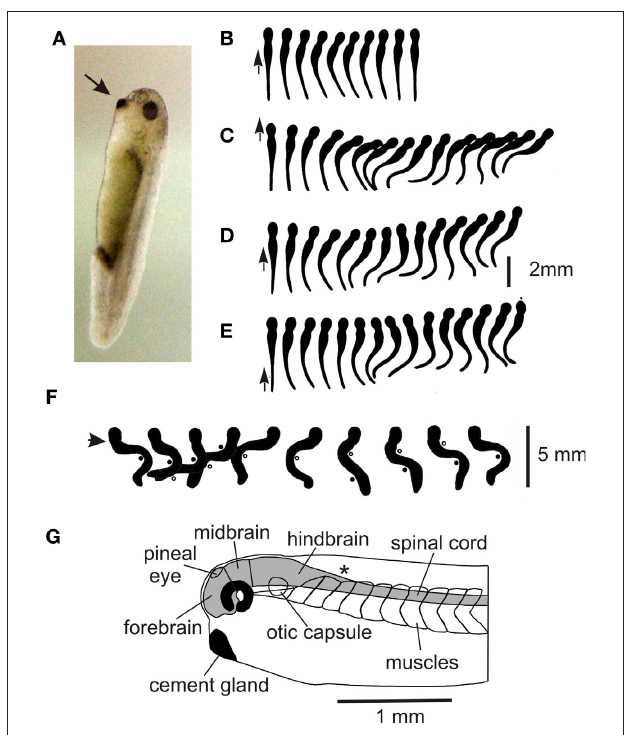
Figure  | Hatchling Xenopus tadpole and its behavior. (A) Stage 37/38 tadpole ( ∼ 5 mm long) at rest hanging by mucus from its cement gland (arrow) attached to the glass side of a tank. (B–e) Response to a short stroke with a hair (small arrow) seen from above in movies at 200 fps. (based on Boothby and Roberts, 1995) (B) Flexion (C–e) swimming (F) struggling when held at the neck (arrow). Points of maximum bending are shown by dots and circles, 64 fps. (based on Kahn and Roberts, 1982b). (g) Side view of the head end to show the main CNS